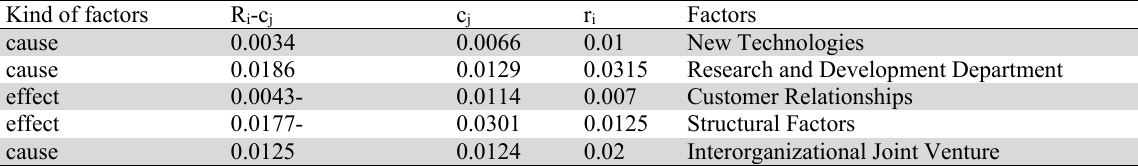
The model of causal relations Kind of factors